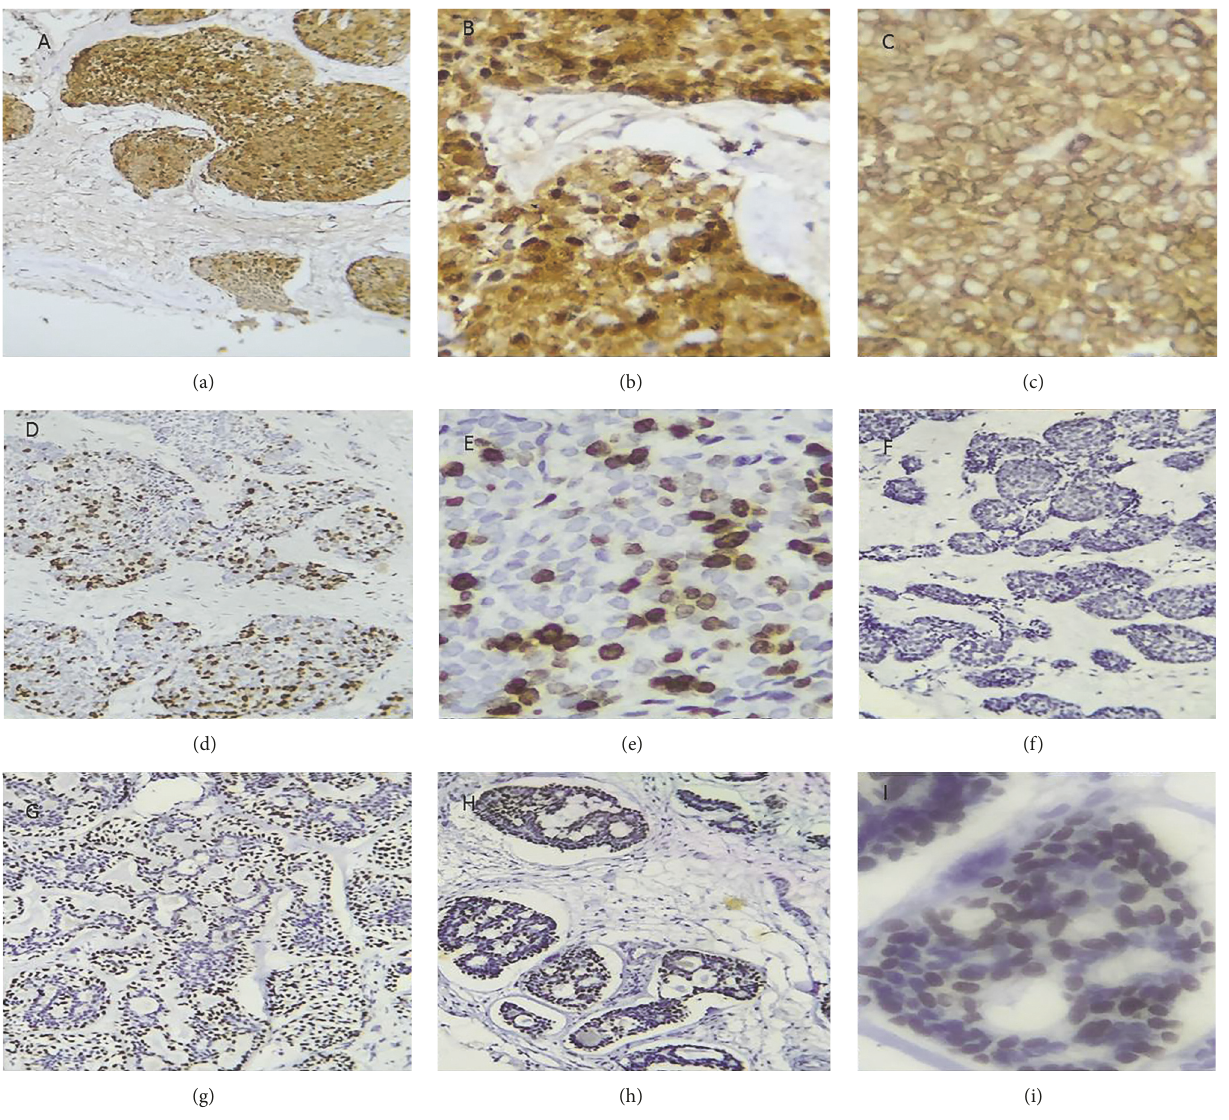
Figure 3: (a), (b) Neoplastic cells have a positive reaction pattern for S-100 (immunohistochemical staining, original magnification, × 20 and × 40). (c) Positive reaction pattern for pan-cytokeratin (IHC staining original magnification × 40). (d), (e) Positive reaction pattern for Ki67 (IHC staining, × 20 and × 40). (f) Negative reaction pattern of neoplastic cells for p63 in initial biopsy specimen (IHC staining, × 20). (g), (h), (i) Positive reaction pattern of neoplastic cells for p63 in secondary excised lesion (immunohistochemical staining, × 20 and ×